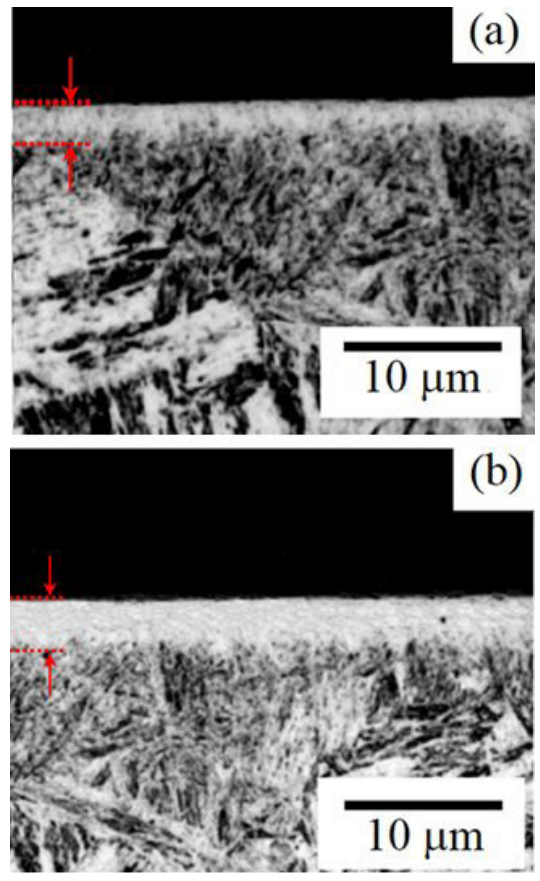
Figure 1. Typical cross-section microstructures of the applied pulse voltage and pressure treatment series obtained at: a) 500 V / 400 Pa; and b) 800 Pa / 700 V, respectively. Treatments carried out at 450 °C, for 8 h, using 99.5% (80% H + 20% Ar) + 0.5% CH gas mixture 2 4 at 1.67 × 10 −6 Nm 3 s −1 flow